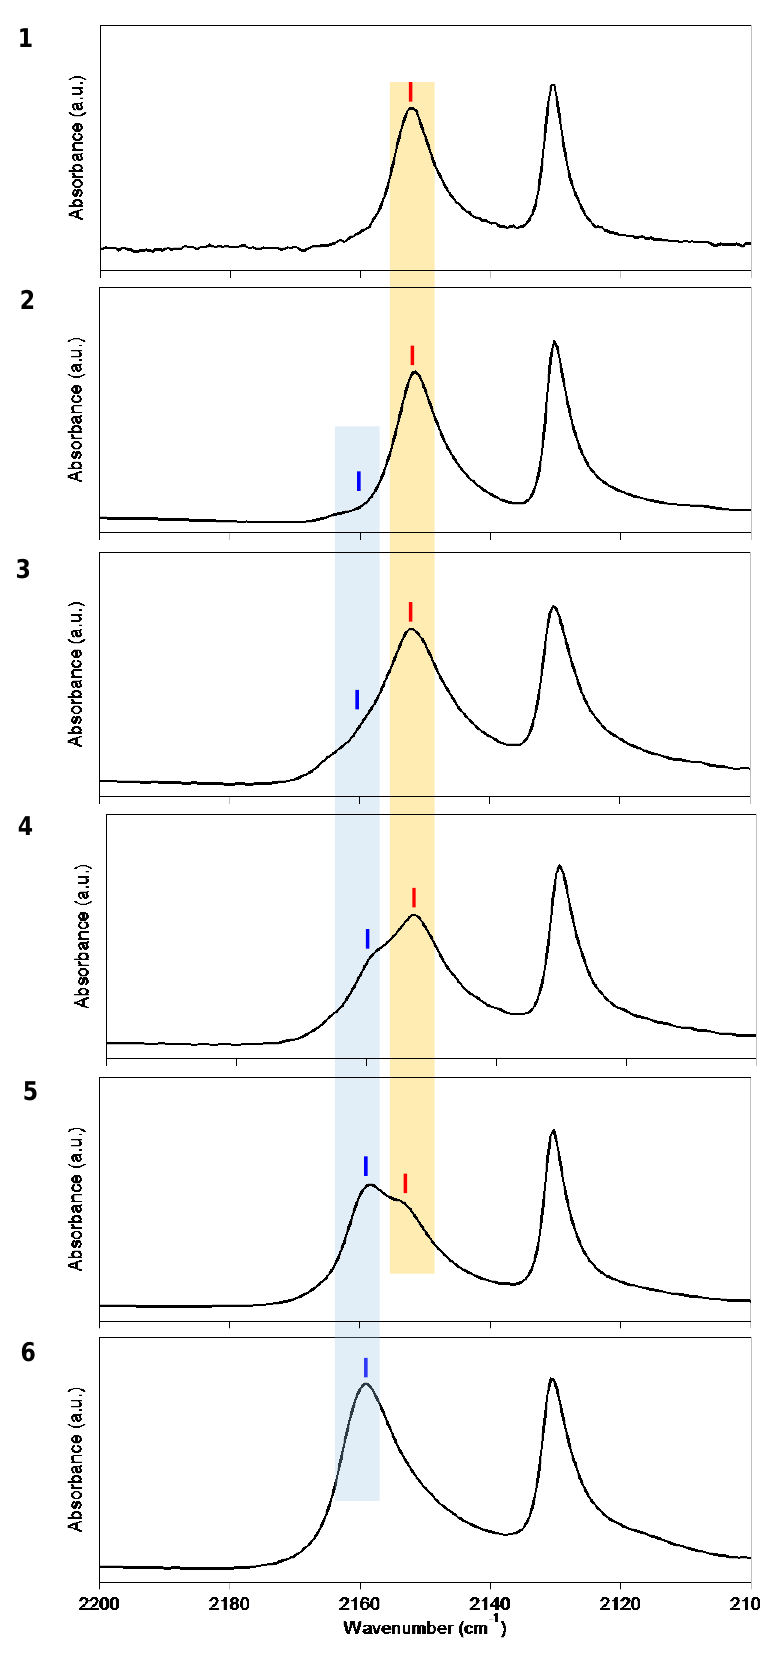
Figure 4. Infrared spectra of 1 – 6 at room temperature for the CN stretching region.